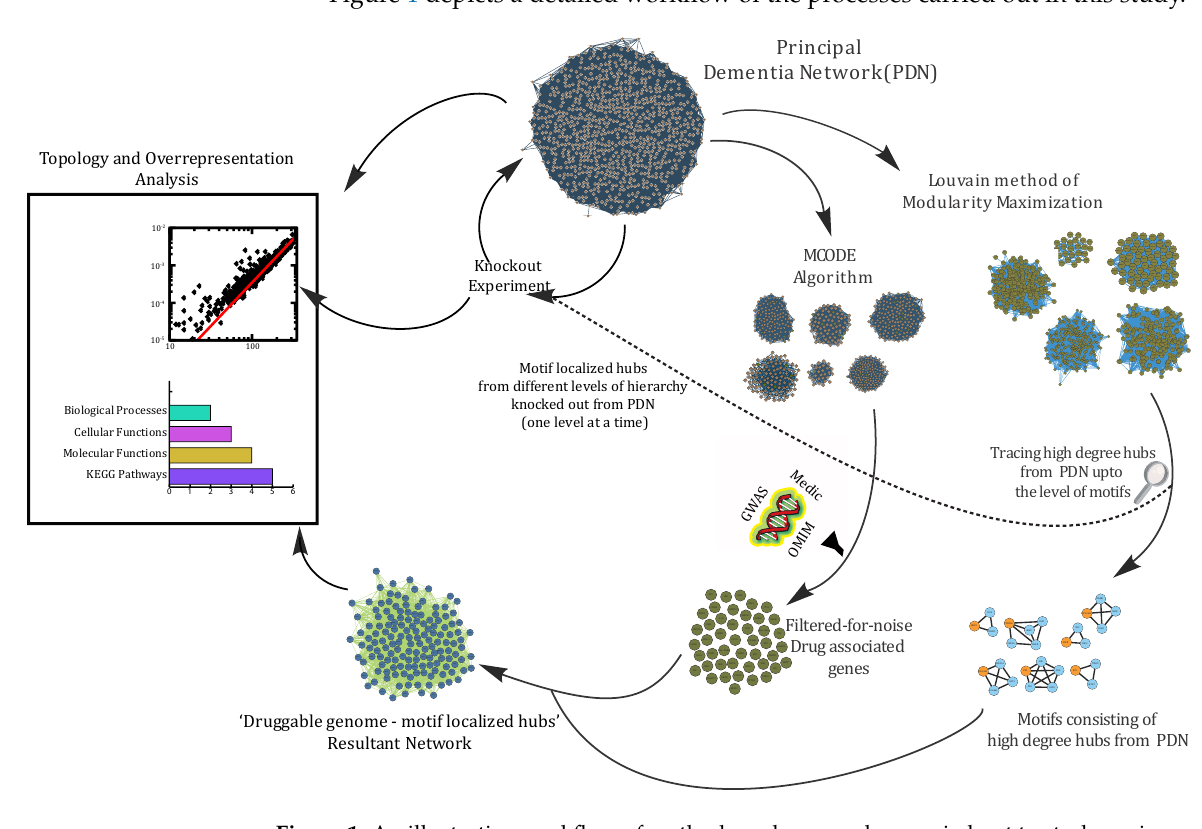
Figure 1. An illustrative workflow of methods and approaches carried out to study various aspects of protein–protein interactions in